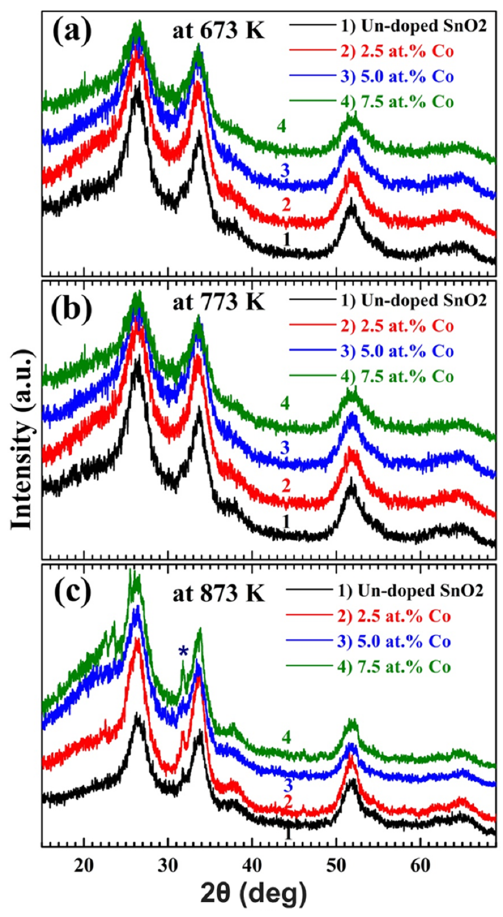
Figure 1. ( a – c ) XRD charts of pure and doped tin oxide films at different annealing temperatures. The sign (*) indicates the formation of the SnO phase at 873 K.